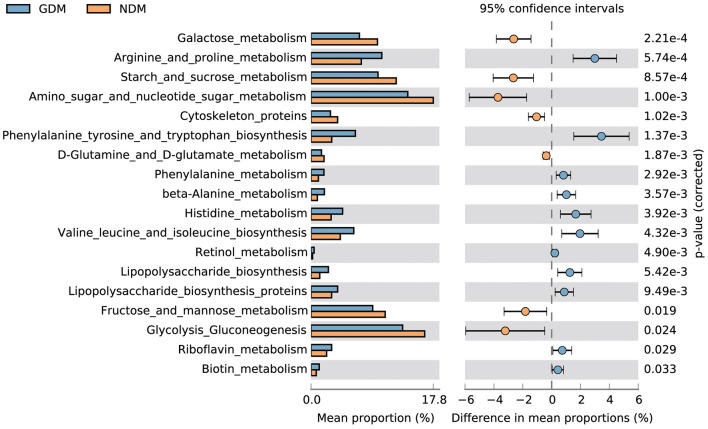
Functional properties of neonatal oral microbiota that differ significantly between GDM and NDM groups.